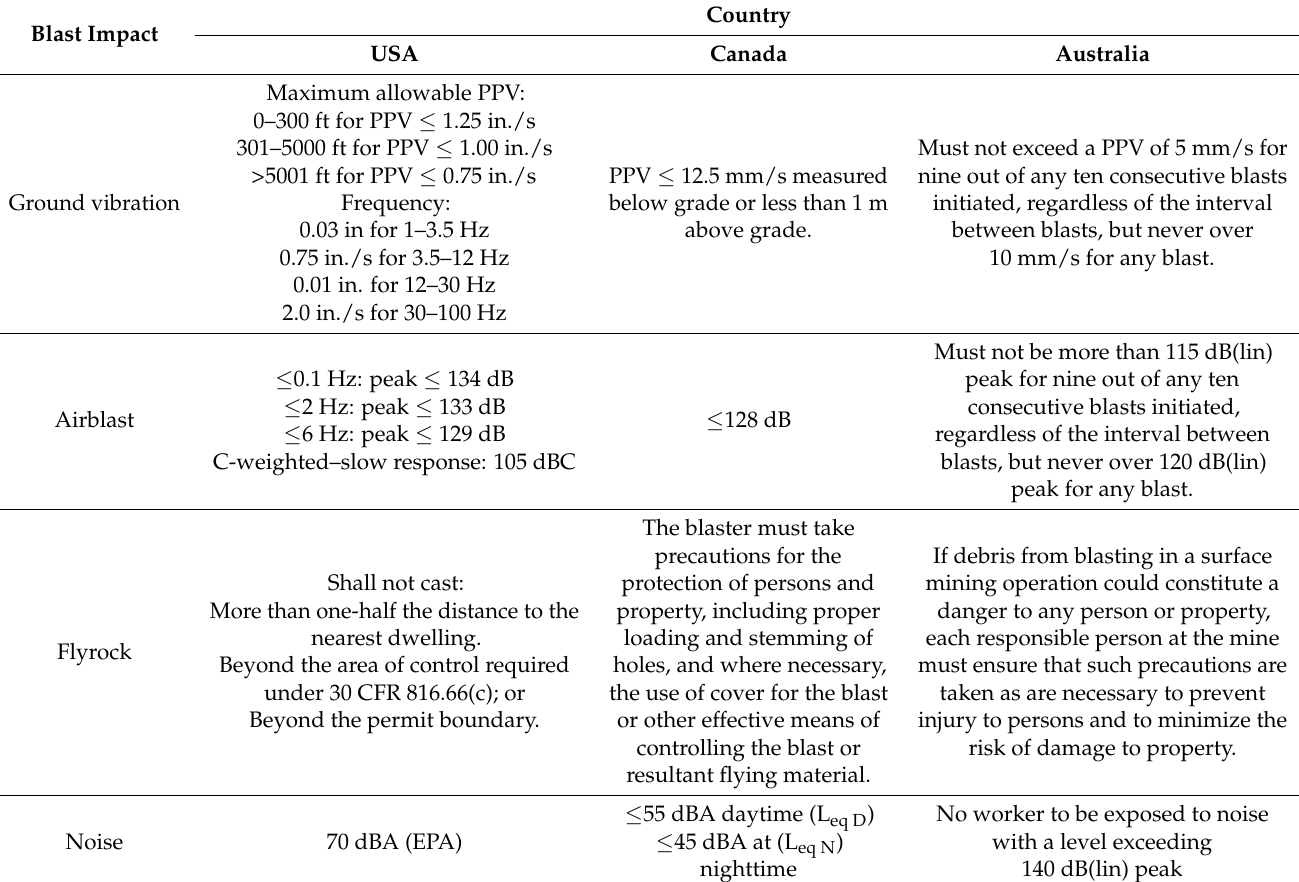
Table 1. Blast standards for the USA, Canada, and